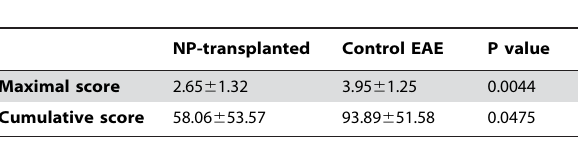
Table 1. Transplantation of hESC-derived NPs significantly attenuates the clinical severity of